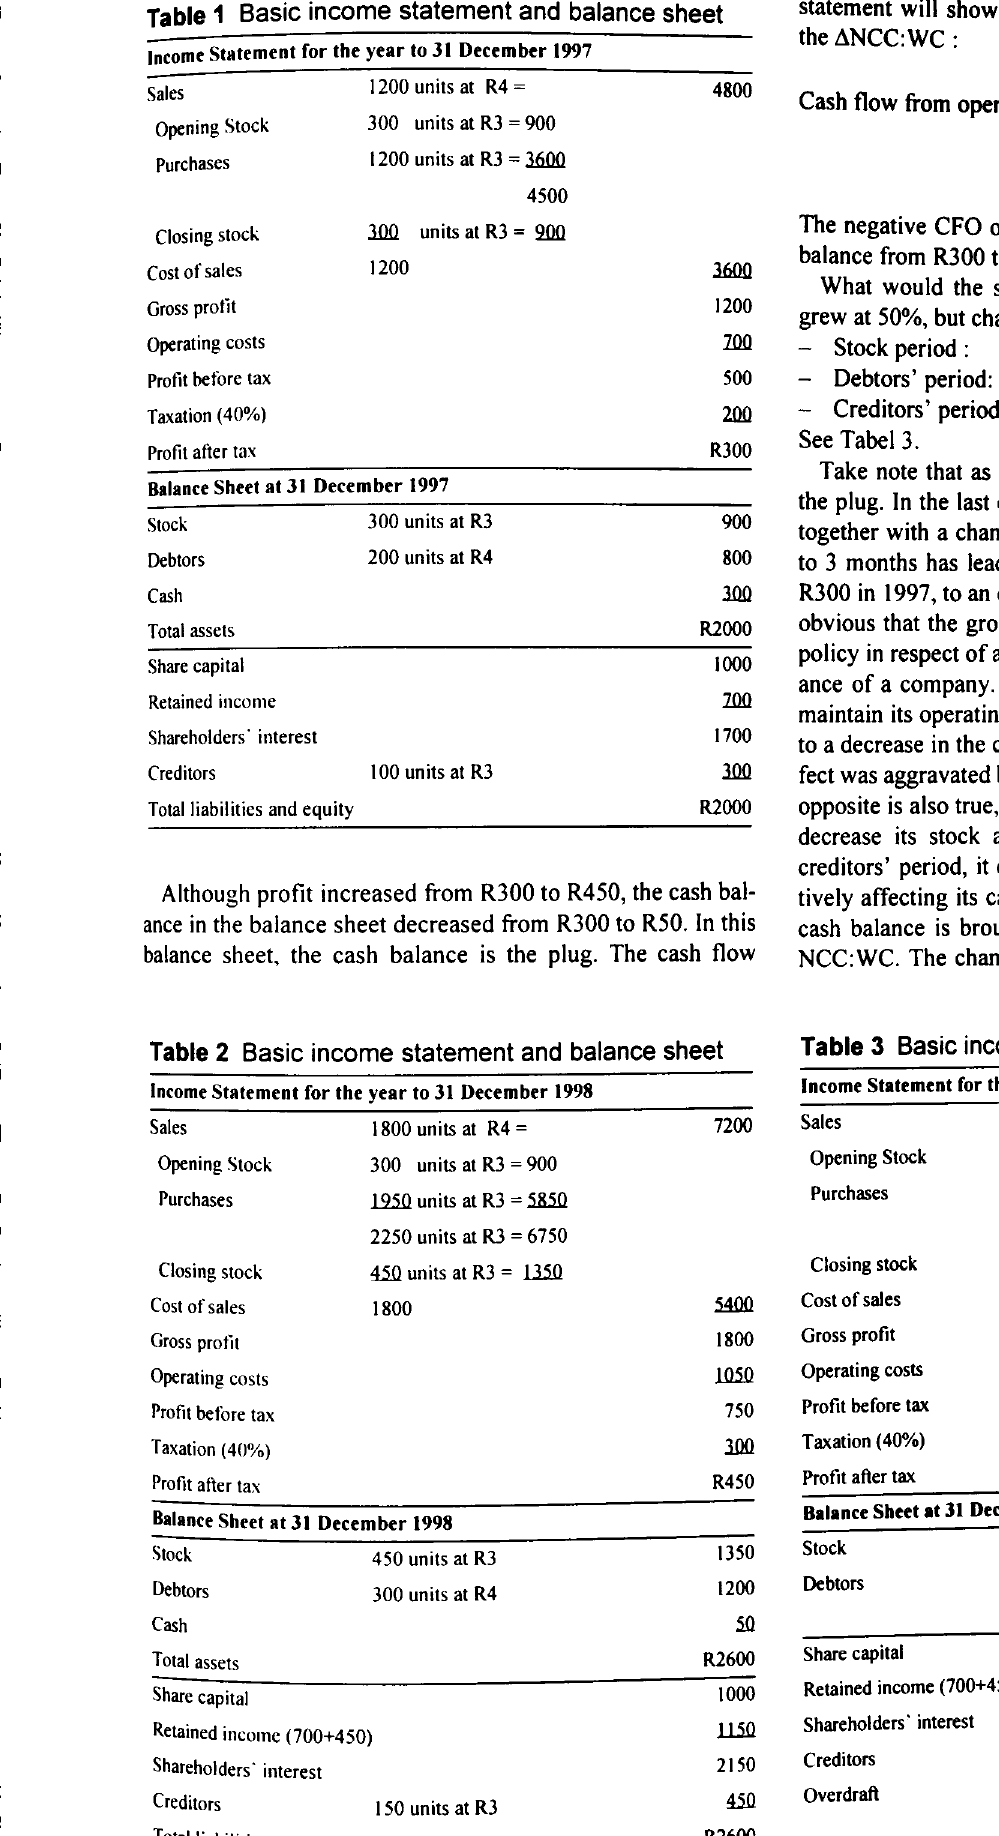
Table 1 Basic income statement and balance